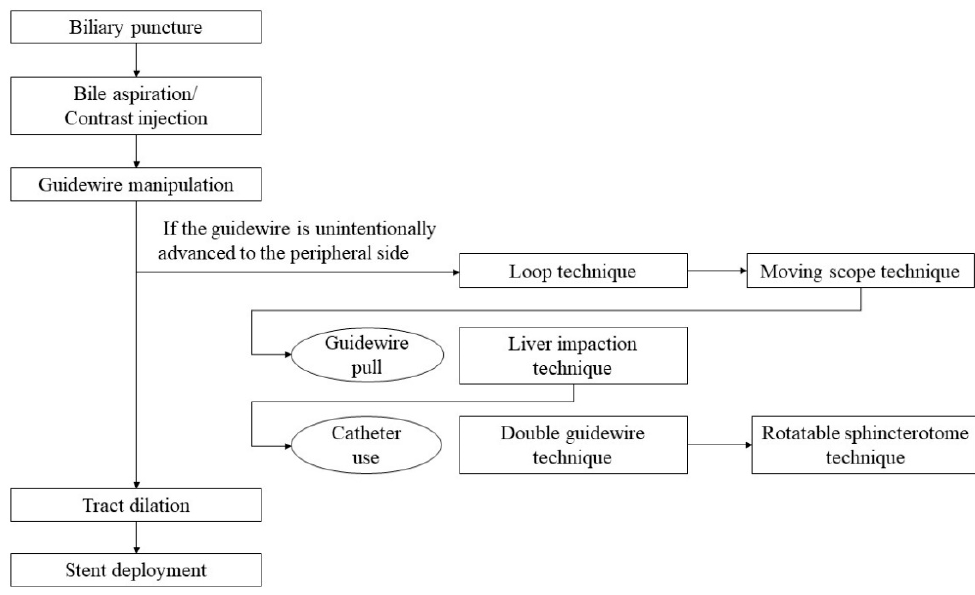
Figure 1. A flow diagram of step-by-step procedures in EUS-HGS.